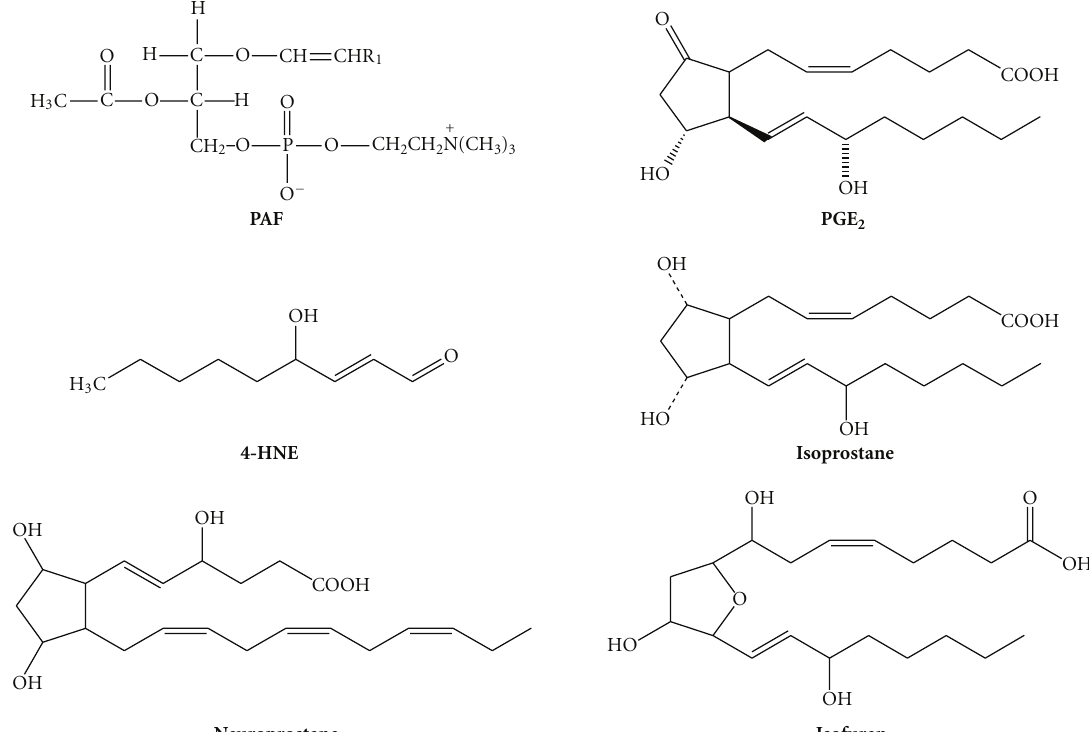
Figure 3: Chemical structures of biomarkers for oxidative